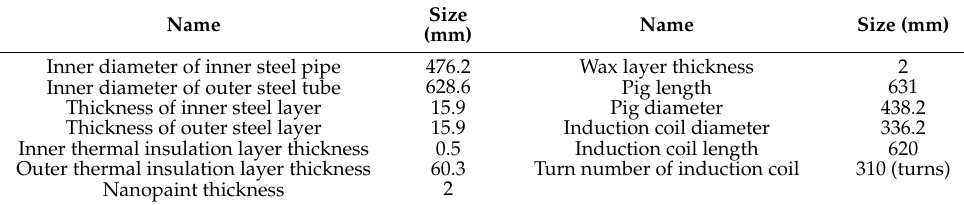
Table 1. Geometric parameters of the pipe wall and electromagnetic pig.